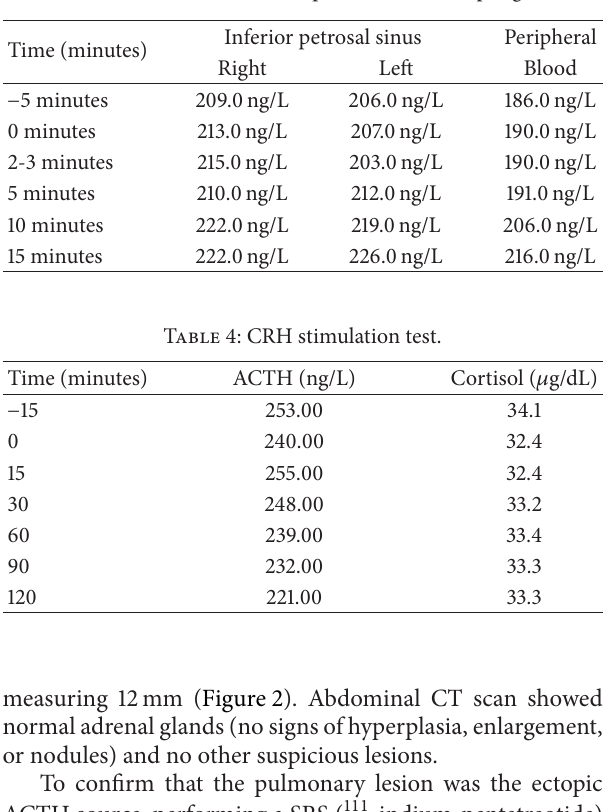
Table 3: Bilateral inferior petrosal sinus sampling.